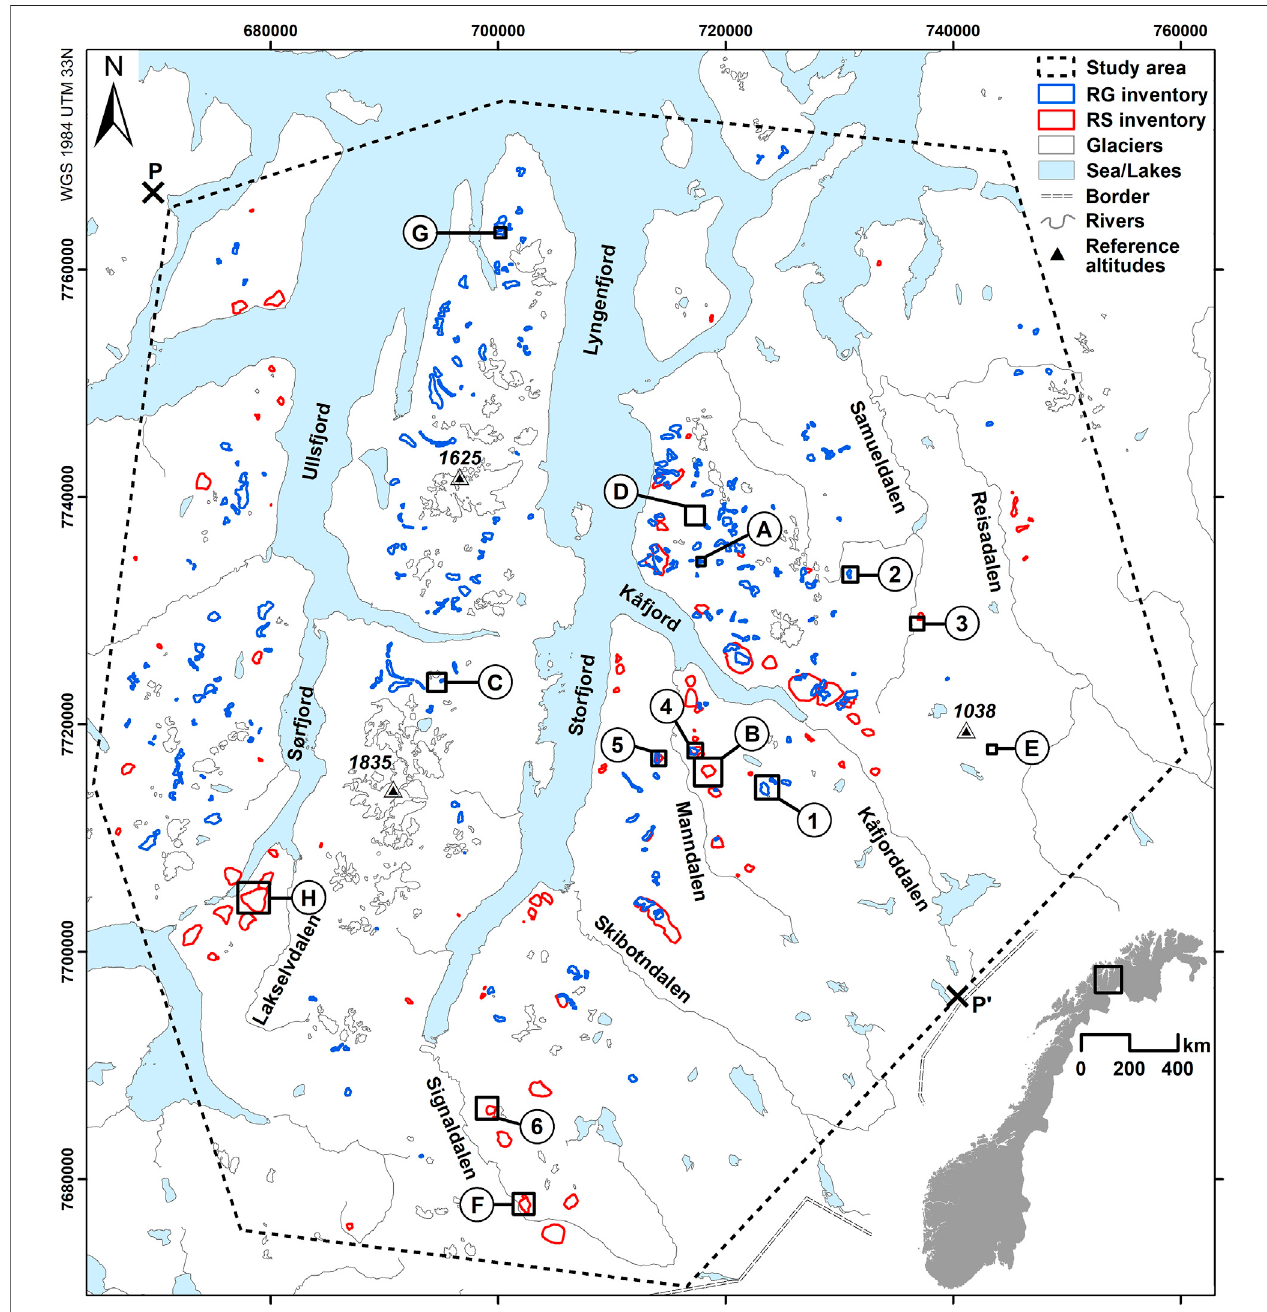
FIGURE1| Location mapofthestudyareainNorthernNorwaywithlandformsfromtheinitialrockglacier(RG)androckslide(RS)inventories.Detailedmaps (A – H) and (1 – 6) are shown in Figures 3 , 6 , 8 , 10 . P – P ’ show the limits of the pro fi le used in Section 6.3 . Global location of Norway in Northern Europe is shown in SupplementaryFigureS1 .GlacierinventoryfromAndreassenandWinsvold(2012)andWinsvoldetal.(2014).Sea,lakes,rivers,borderandreferencealtitudes/names from NMA (2020a).